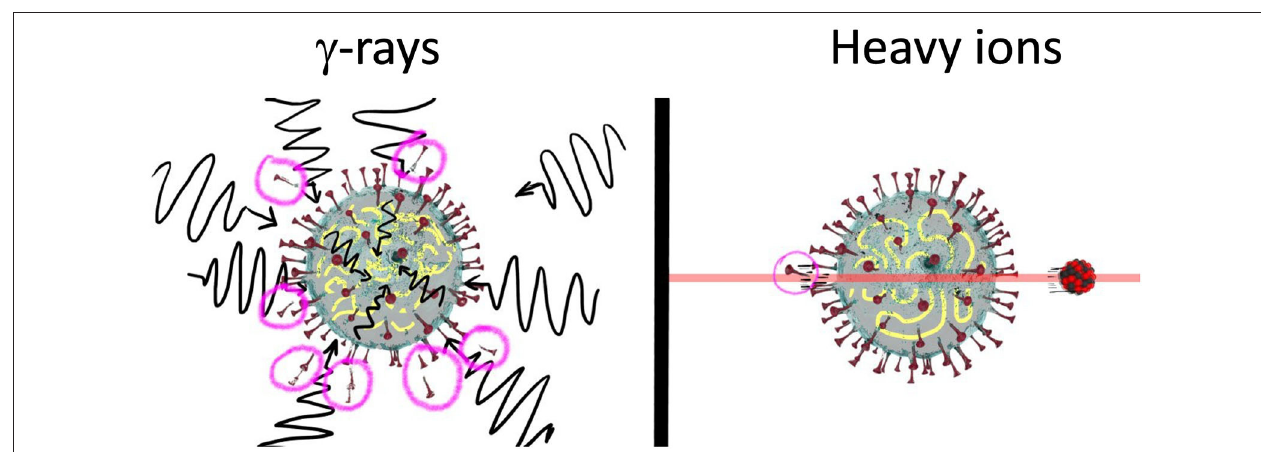
FIGURE 5 | High- and low-LET radiation for virus inactivation. Schematic representation of the action of sparsely and densely ionizing radiation on SARS-CoV-2. High doses of γ -rays can inactivate the virus, but will damage many membrane proteins, whereas single (or few) heavy ion traversals will produce limited membrane damage while maintaining a high inactivation probability. Sparing of membrane epitopes is essential to elicit the immune response toward vaccine generation.